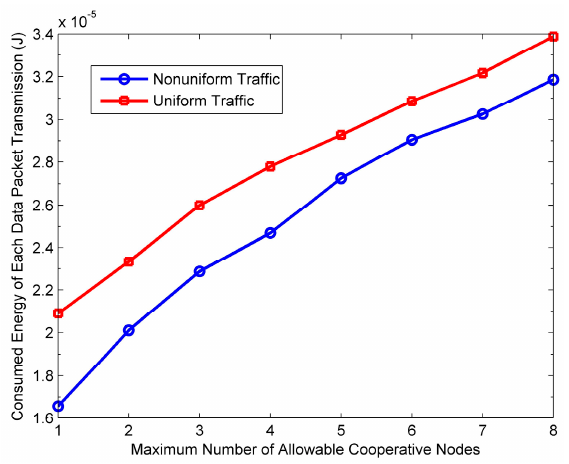
Figure 18. Average consumed energy of each data packet transmission vs. M .